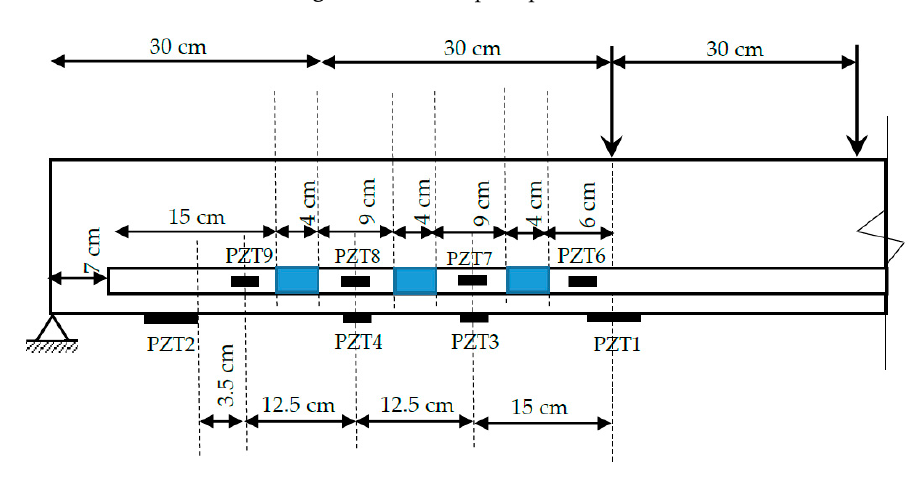
Figure 2. Test setup of specimen B.